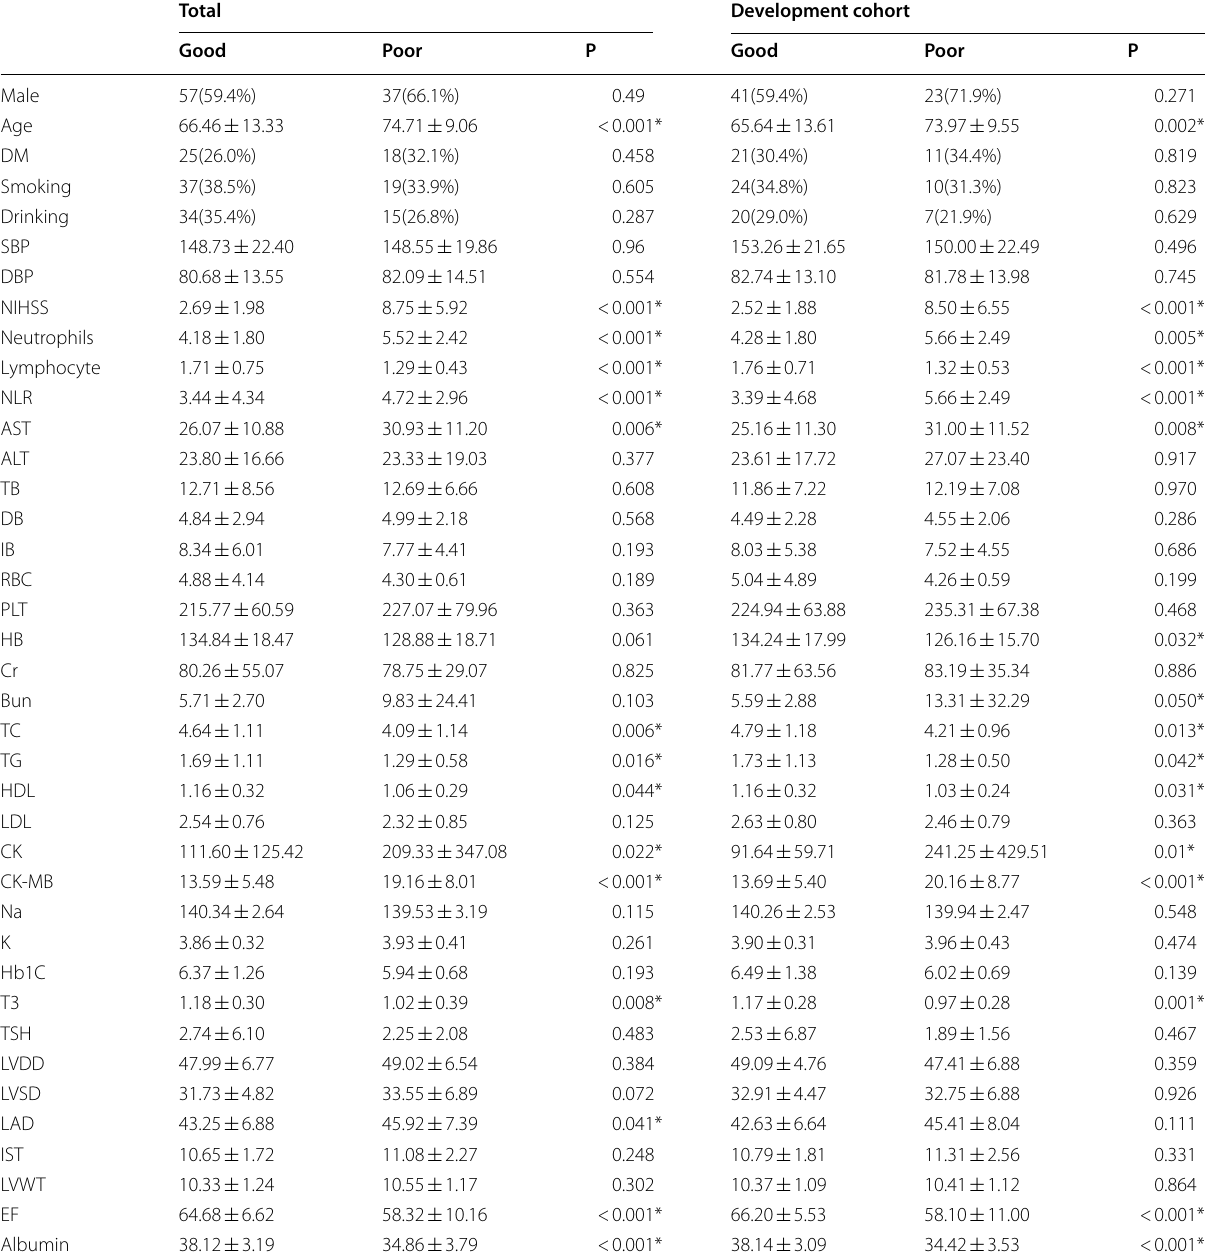
Table 1 Demographic and clinical